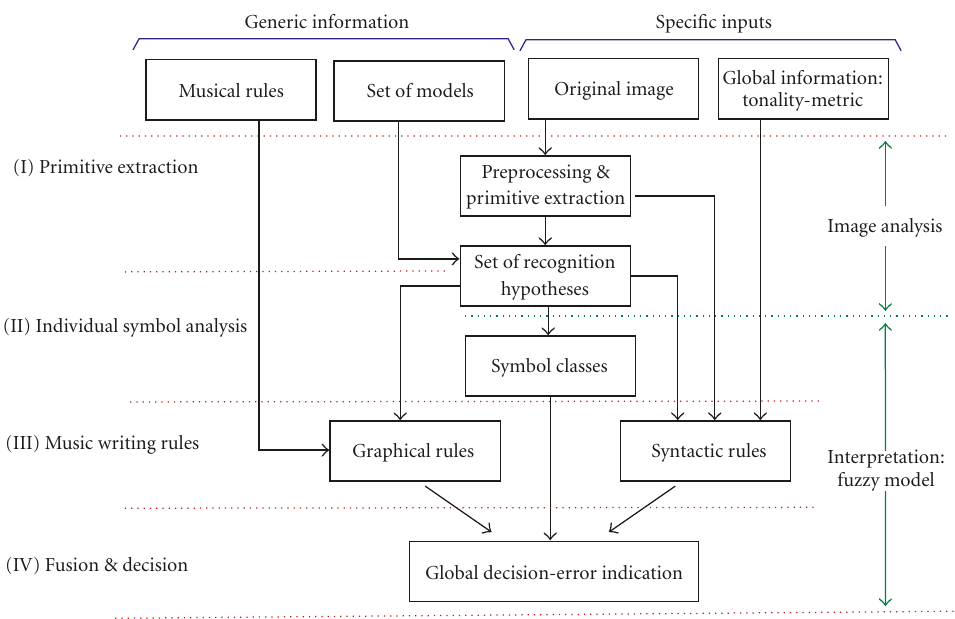
Figure 5: Overview of the proposed